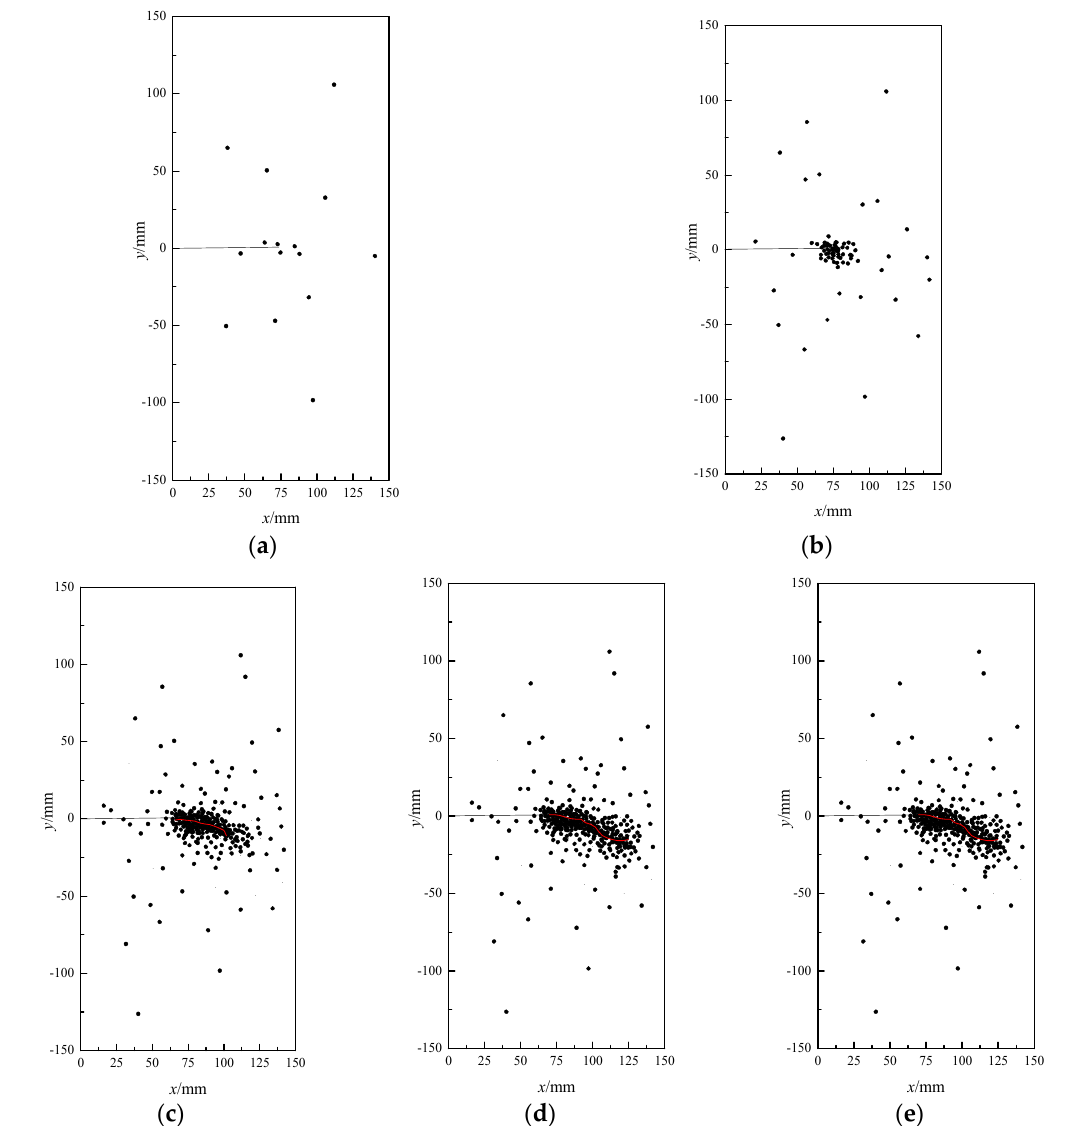
Figure 7. Testing results of AE events location during crack frost-heave propagation. ( a ) Less and scattered, stage 1; ( b ) concentrated the tip of initial crack, stage 2; ( c ) densely distributed along the initial crack direction, stage 3; ( d ) the distribution extends slightly, stage 4; ( e ) unchanged distribution, stage 5.